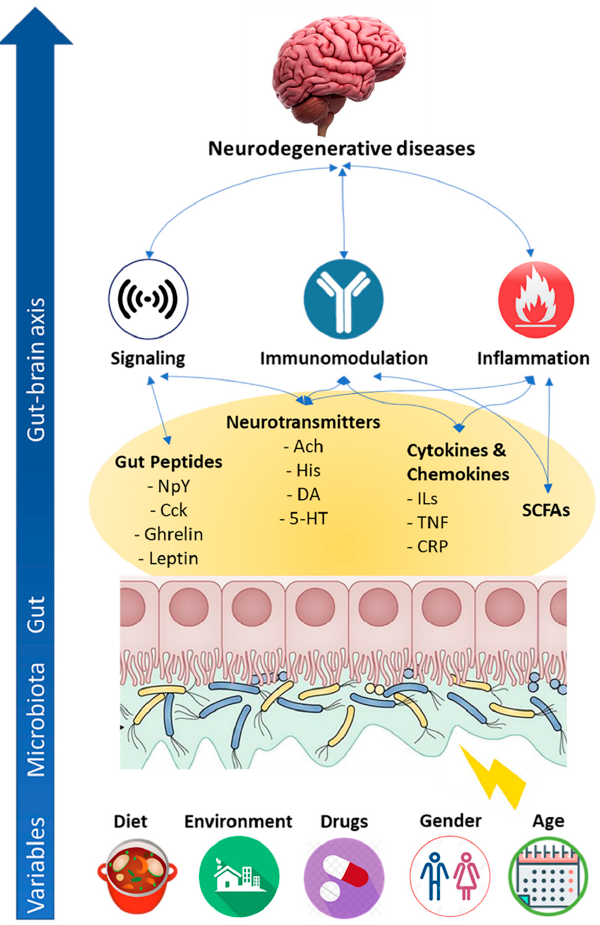
Figure 1. Major mechanisms employed by gut microbiota to impact neurodegenerative diseases. The